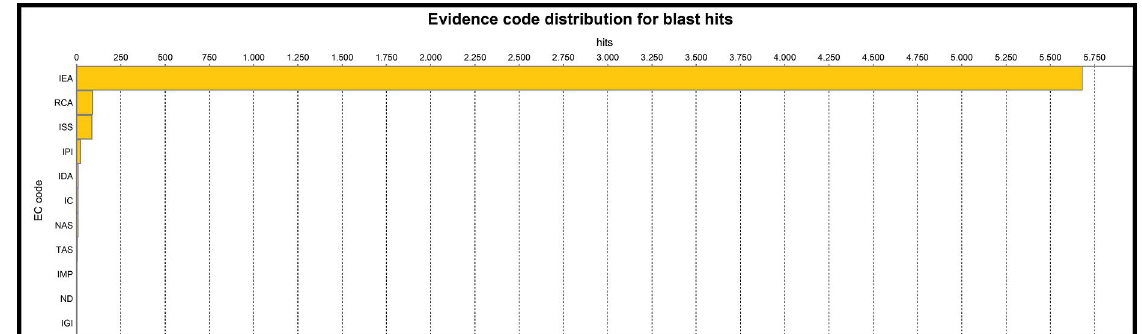
Figure S6: EC (Evidence Code) distribution for the EST-Contigs blast hits. IEA = Inferred from Electronic Annotation. ISS = Inferred from Sequence or Structural Similarity. RCA = Inferred from Reviewed Computational Analysis. IPI = Inferred from Physical Interaction. IDA = Inferred from Direct Assay. IC = Inferred by Curator. NAS = Non-traceable Author Statement. TAS = Traceable Author Statement. ND = No biological Data available. IMP = Inferred from Mutant Phenotype. IGI = Inferred from Genetic